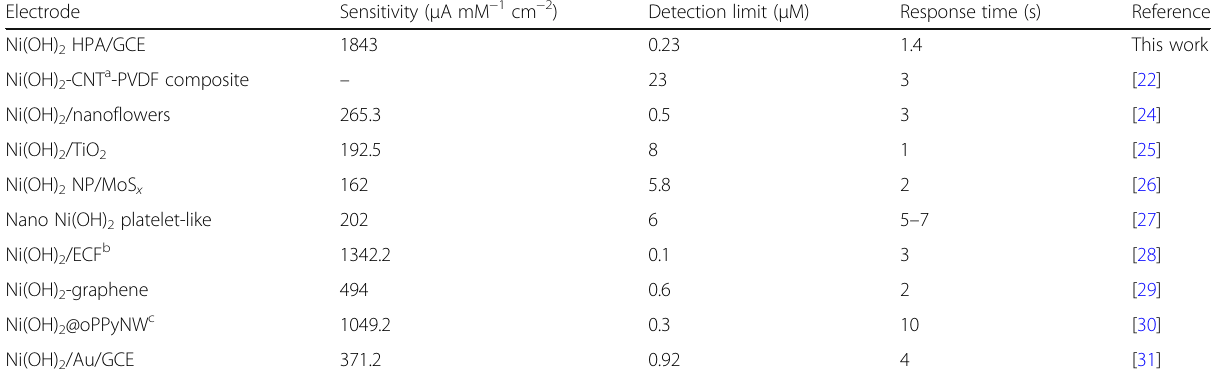
Table 1 Comparison of researched electrode with reported nonenzymatic glucose sensors based on Ni(OH) 2